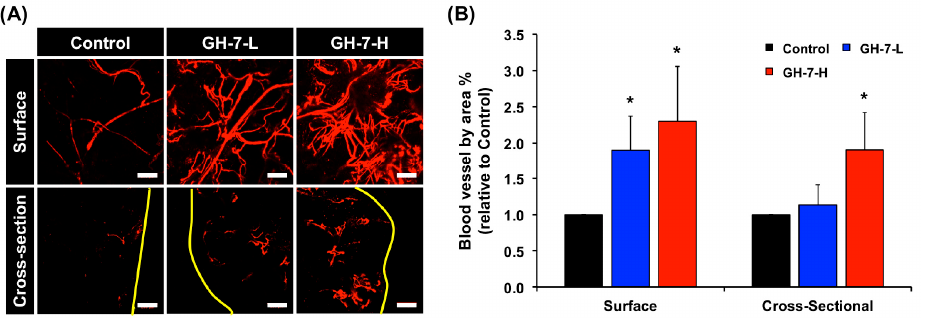
Figure 4. In vivo vascularization of hMSCs with GH hydrogels subcuntaneously delivered into nude mice. Representative images (surface and cross-section) of perfusable vasculature from delivered hMSCs in the GH gel loaded on polyvinyl alcohol (PVA) implants at two weeks post implantation. Yellow lines mark the surface boundaries of implants, and scale bars indicate 200 µm ( A ); Relative ratio of functional blood vessels by crosslinked GH-7-L and GH-7-H gels compared to non-crosslinked GH control (ratio = 1). * p < 0.05 vs. Control ( n = 3, from mixed donor cell groups) ( B ).